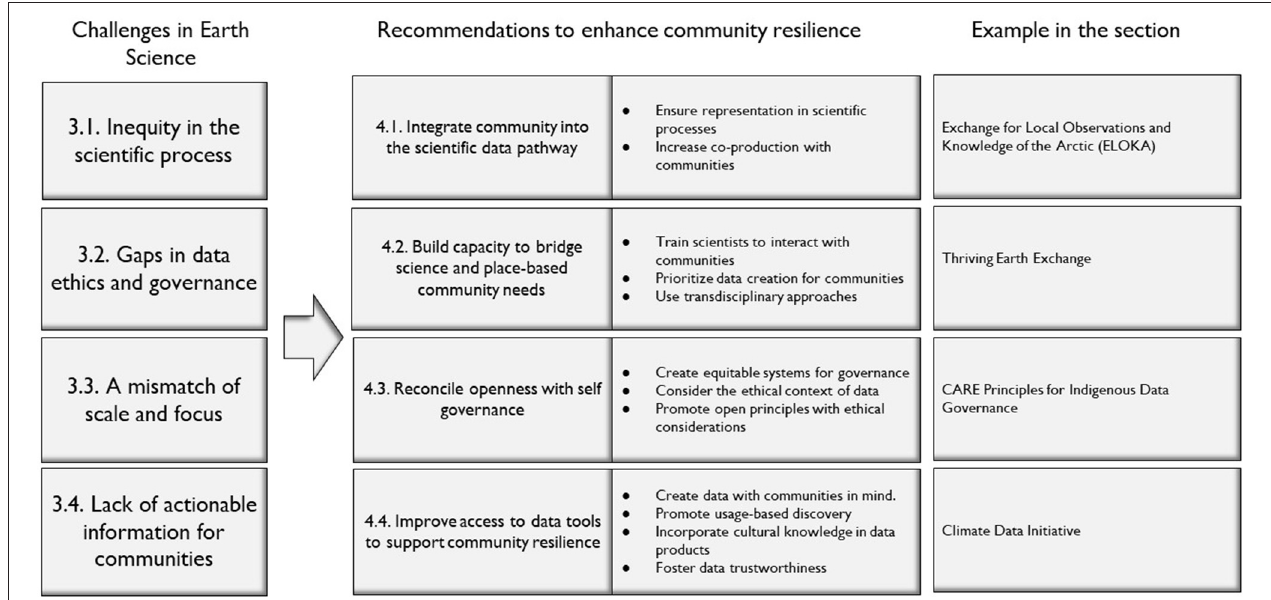
FIGURE 3 | Recommendations to the Earth sciences as to how changes in Earth science can enhance community resilience, stemming from the challenges described in this